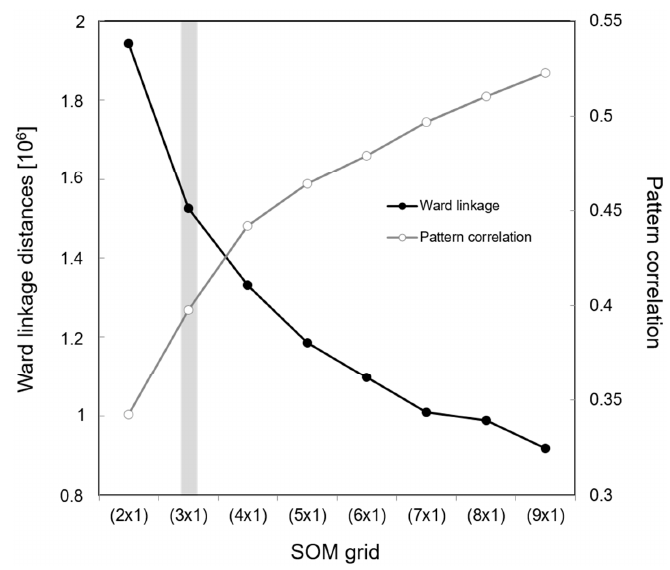
Figure 1. Ward linkage distances between the self-organizing maps (SOM) patterns (open circle, left y-axis) and mean pattern correlations between the daily mean sea-level pressure (MSLP) fields and their best-matching SOM pattern (closed circle, right y-axis) as a function of SOM grid from (2 × 1) to (9 ×